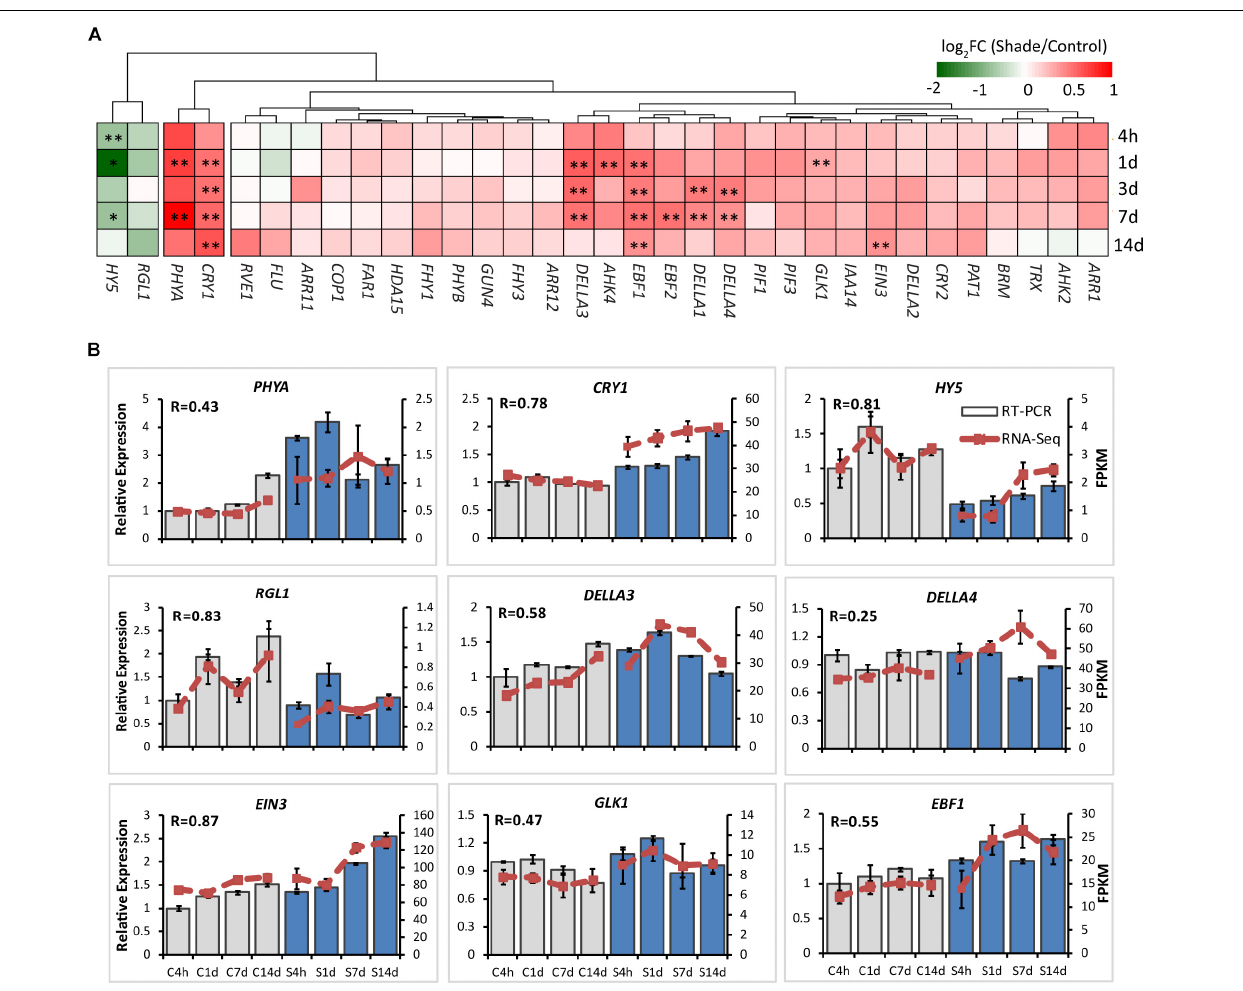
FIGURE 5 | Effect of shade on key genes and TFs involved in the light- and hormone regulation of chlorophyll biosynthesis. (A) Transcript abundance of representative unigenes involved in the light and hormone regulation of the chlorophyll biosynthesis generated from RNA-Seq analysis. (B) Transcript abundance of selected unigenes validated by the RT-PCR analysis. The column presents data generated from the RT-PCR analysis (gray column, data from the control treatment at four time points; blue column, data from the shade treatment at four time points). The line presents data generated from the RNA-Seq analysis. The transcript abundance in the control treatment at 4 h (C4h) was set at 1. R, the correlation factor between RT-PCR and RNA-Seq analysis for each gene/TF according to SPSS 13.0 software. Data shown are conducted of three independent biological replicates ( n = 3). The annotations of 4h, 1d, 3d, 7d, 14d, C, S, FPKM and statistical label (*) are shown as in Figure 3 . For abbreviations, see